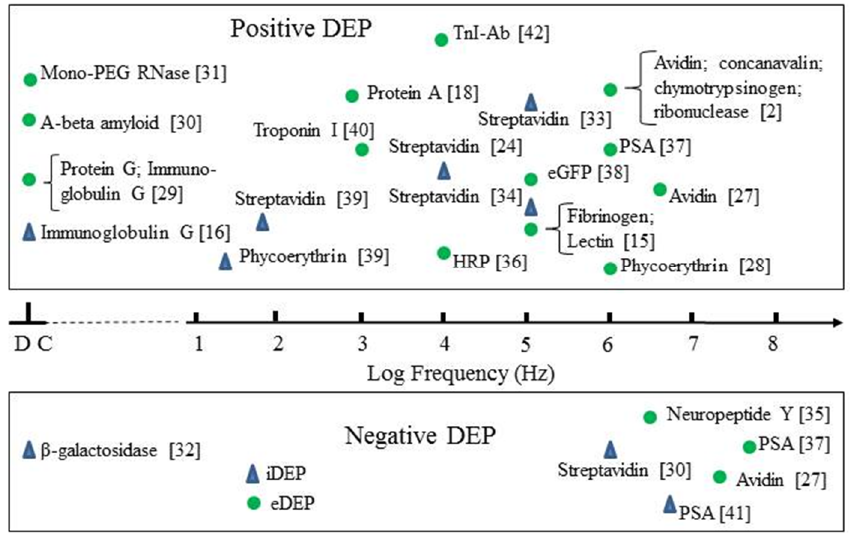
Figure 5. A summary of the DEP responses, at specific frequencies of the applied field, for proteins other than BSA. (HRP: horse radish peroxidase; PSA: prostate specific antigen; eGFP: enhanced green fluorescent protein; TnI-Ab: troponin I antibody).